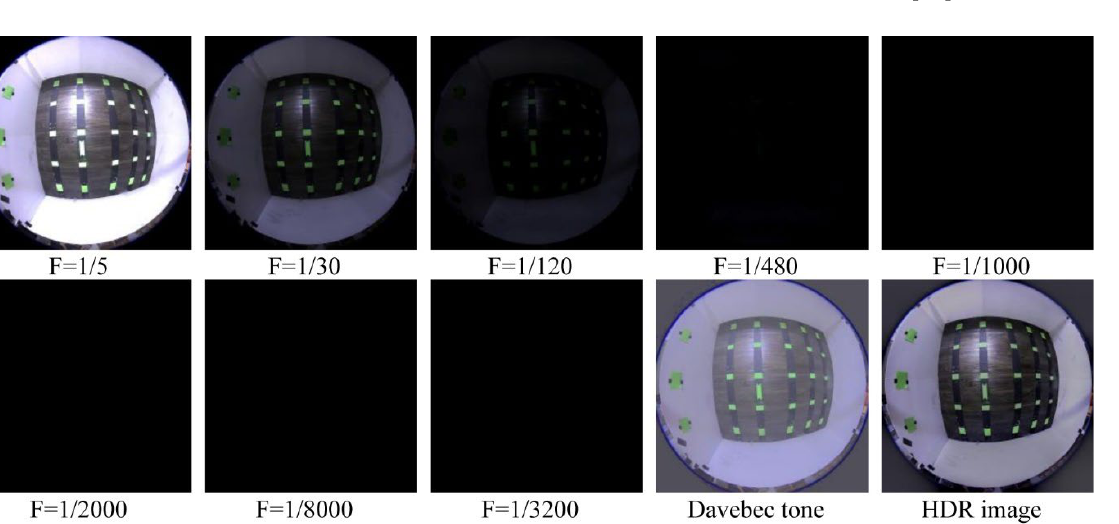
Figure 2. Control system framework.